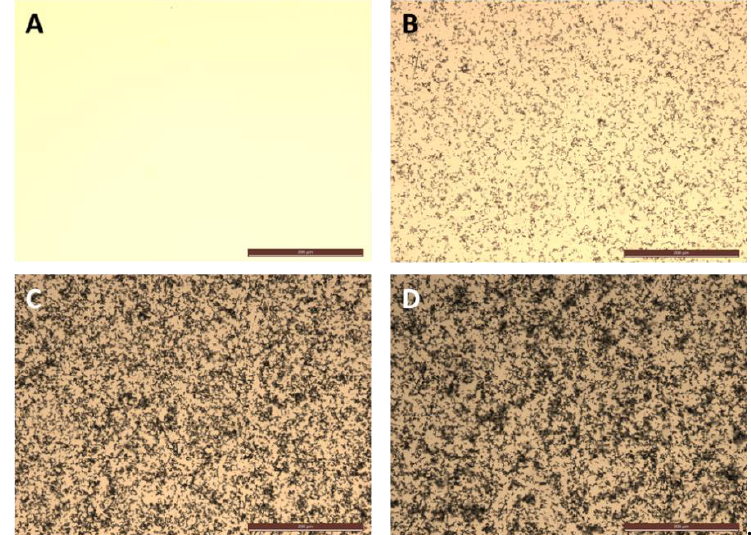
Figure 2. Formation of polydopamine (PDA) after five hours of introducing dopamine (DA) to 100 sodium bicarbonate bu ff er at pH 8.5. ( A ) Sodium bicarbonate bu ff er; ( B ) 25 µ M dopamine in the bu ff er; mM sodium bicarbonate buffer at pH 8.5. ( A ) Sodium bicarbonate buffer; ( B ) 25 µM dopamine in the ( C ) 75 µ M dopamine in bu ff er; and ( D ) 125 µ M dopamine in the bu ff er. Scale bar indicates 100 µ m in buffer; ( C ) 75 µM dopamine in buffer; and ( D ) 125 µM dopamine in the buffer. Scale bar indicates 100 all µm in all panels.